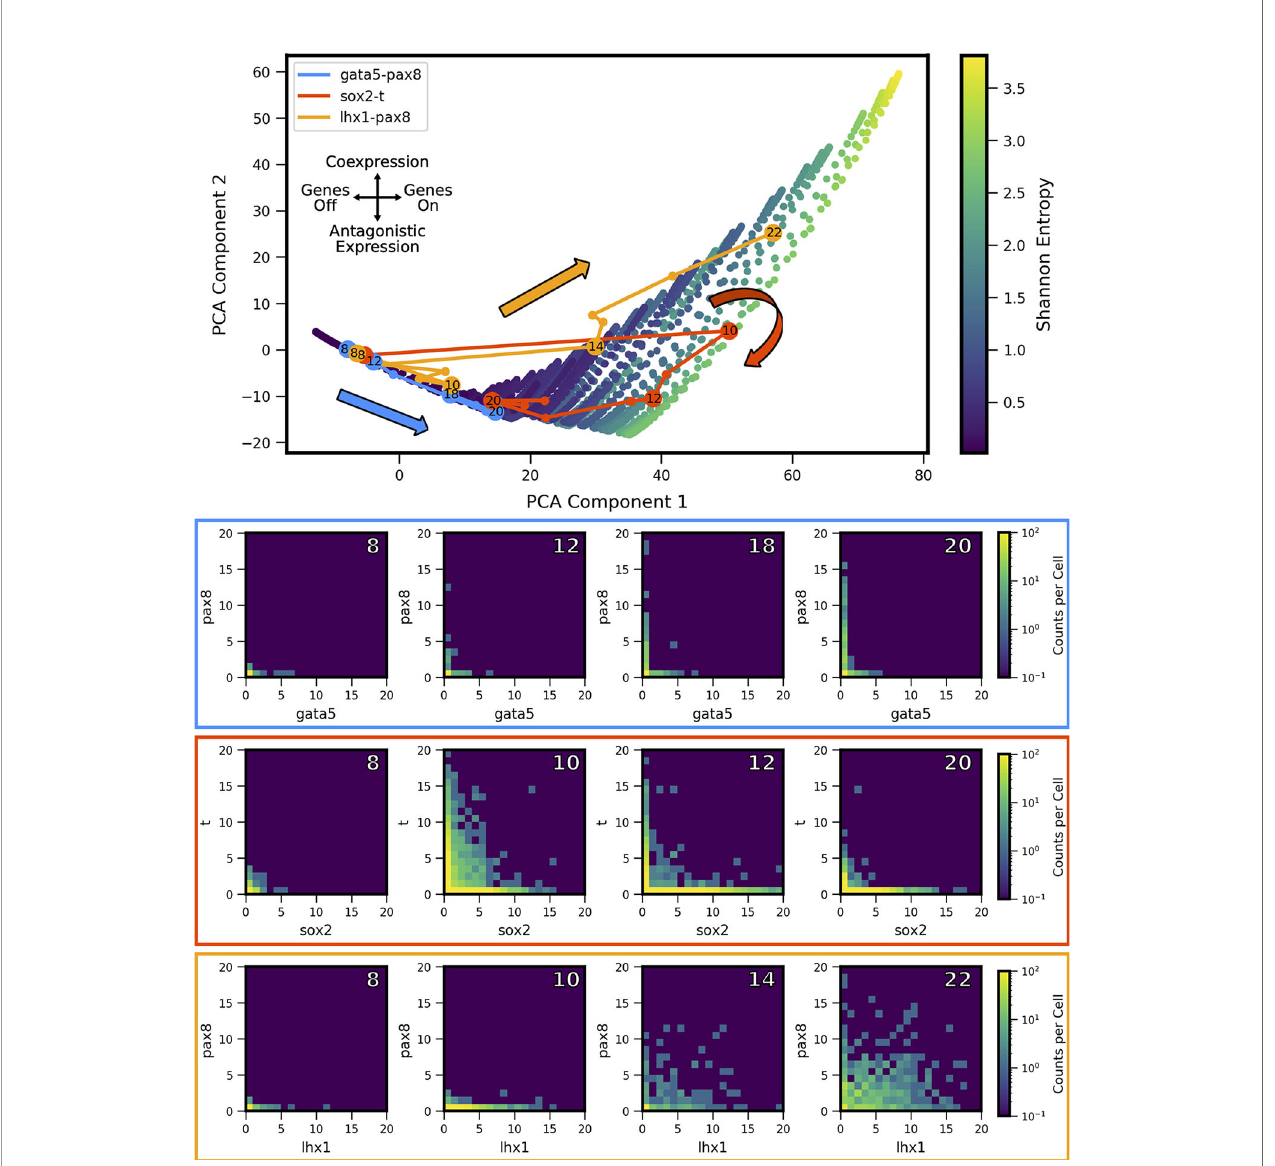
FIGURE 6 | Landscape-shape trajectories of three representative gene pairs from scRNA-seq measurements in Xenopus tropicalis embryonic development. (Top) Developmental trajectories of three different gene pairs, plotted in principal component-space. Stages of interest shown below are labeled with the corresponding stage. Note the three stage 8 points are overlapping near the origin as a result of low expression. (Bottom) Coexpression quasipotential landscapes extracted from experimental measurements for the three gene pairs at different labeled stages of embryonic development (white numbers indicate developmental stage). The experiment-derived landscapes were trained on the principal components generated from the simulated MISA dataset of Figure 5 . Principal component 1 corresponds to overall level of expression, while component 2 separates antagonistic vs. coexpression (see Figure 7 ). The landscape of gata5-pax8 (blue) shows increasing antagonistic expression, consistent with movement along the lower left edge of the triangle in Principal Component Analysis (PCA) shape-space. Sox2-t (red) shows high coexpression at stage 10, followed by later antagonistic expression, corresponding to a partial loop through PCA space, consistent with Multilineage Priming behavior. Lhx1-pax8 (orange) shows consistently increasing coexpression, corresponding to a mostly steady increase in principal components 1 and 2. (Data from Briggs et al.,